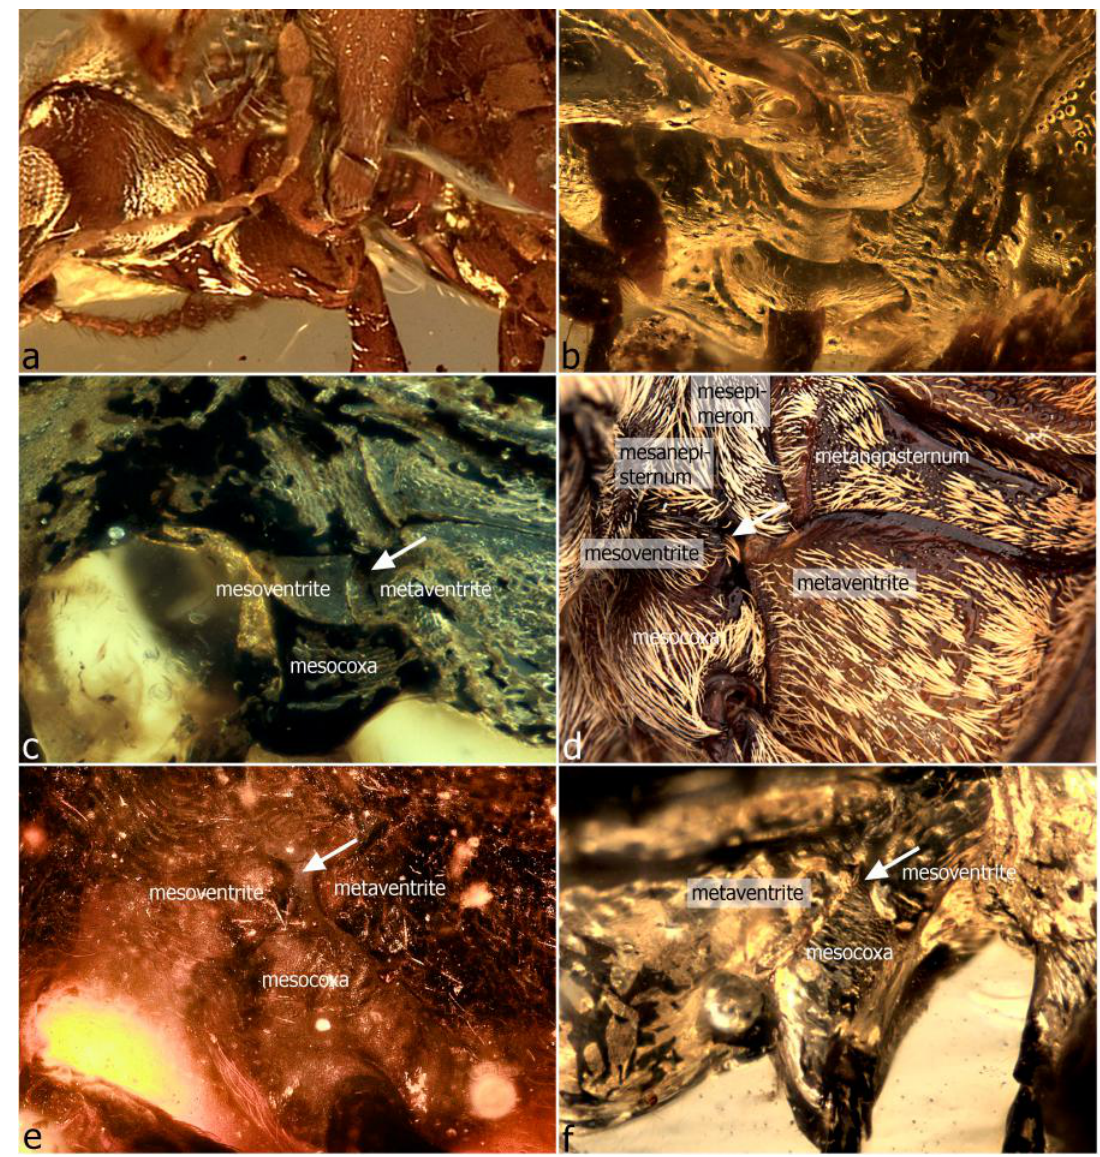
Figure 8. Procoxal and mesocoxal cavities in Burmese amber weevils. Confluent proxocal cavities (contiguous procoxae), Elwoodius conicops (Mesophyletidae) ( a ); separated proxocal cavities (procoxae), Petalotarsus oxycorynoides (Mesophyletidae) ( b ); closed mesocoxal cavity (suture arrowed), Acalyptopygus brevicornis (Mesophyletidae) ( c ); open mesocoxal cavity (suture arrowed), Hadrobelus undulatus (Belidae) ( d ); open mesocoxal cavity (suture arrowed), Platychirus beloides (Mesophyletidae) ( e ); open mesocoxal cavity (suture arrowed), Rhynchitomimus chalybeus (Mesophyletidae) ( f ).